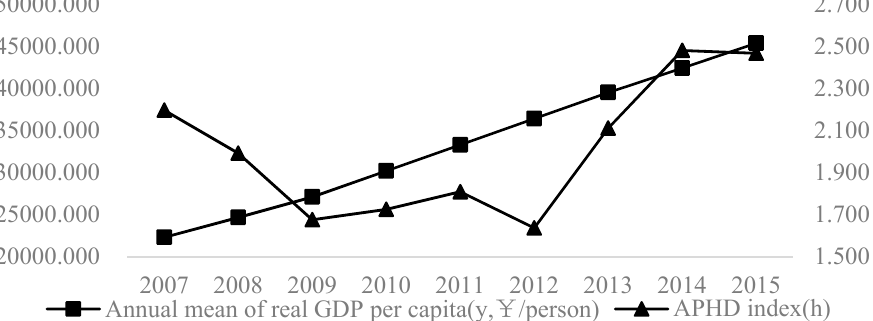
Figure 2. Average change of economic growth and APHD during the study period .